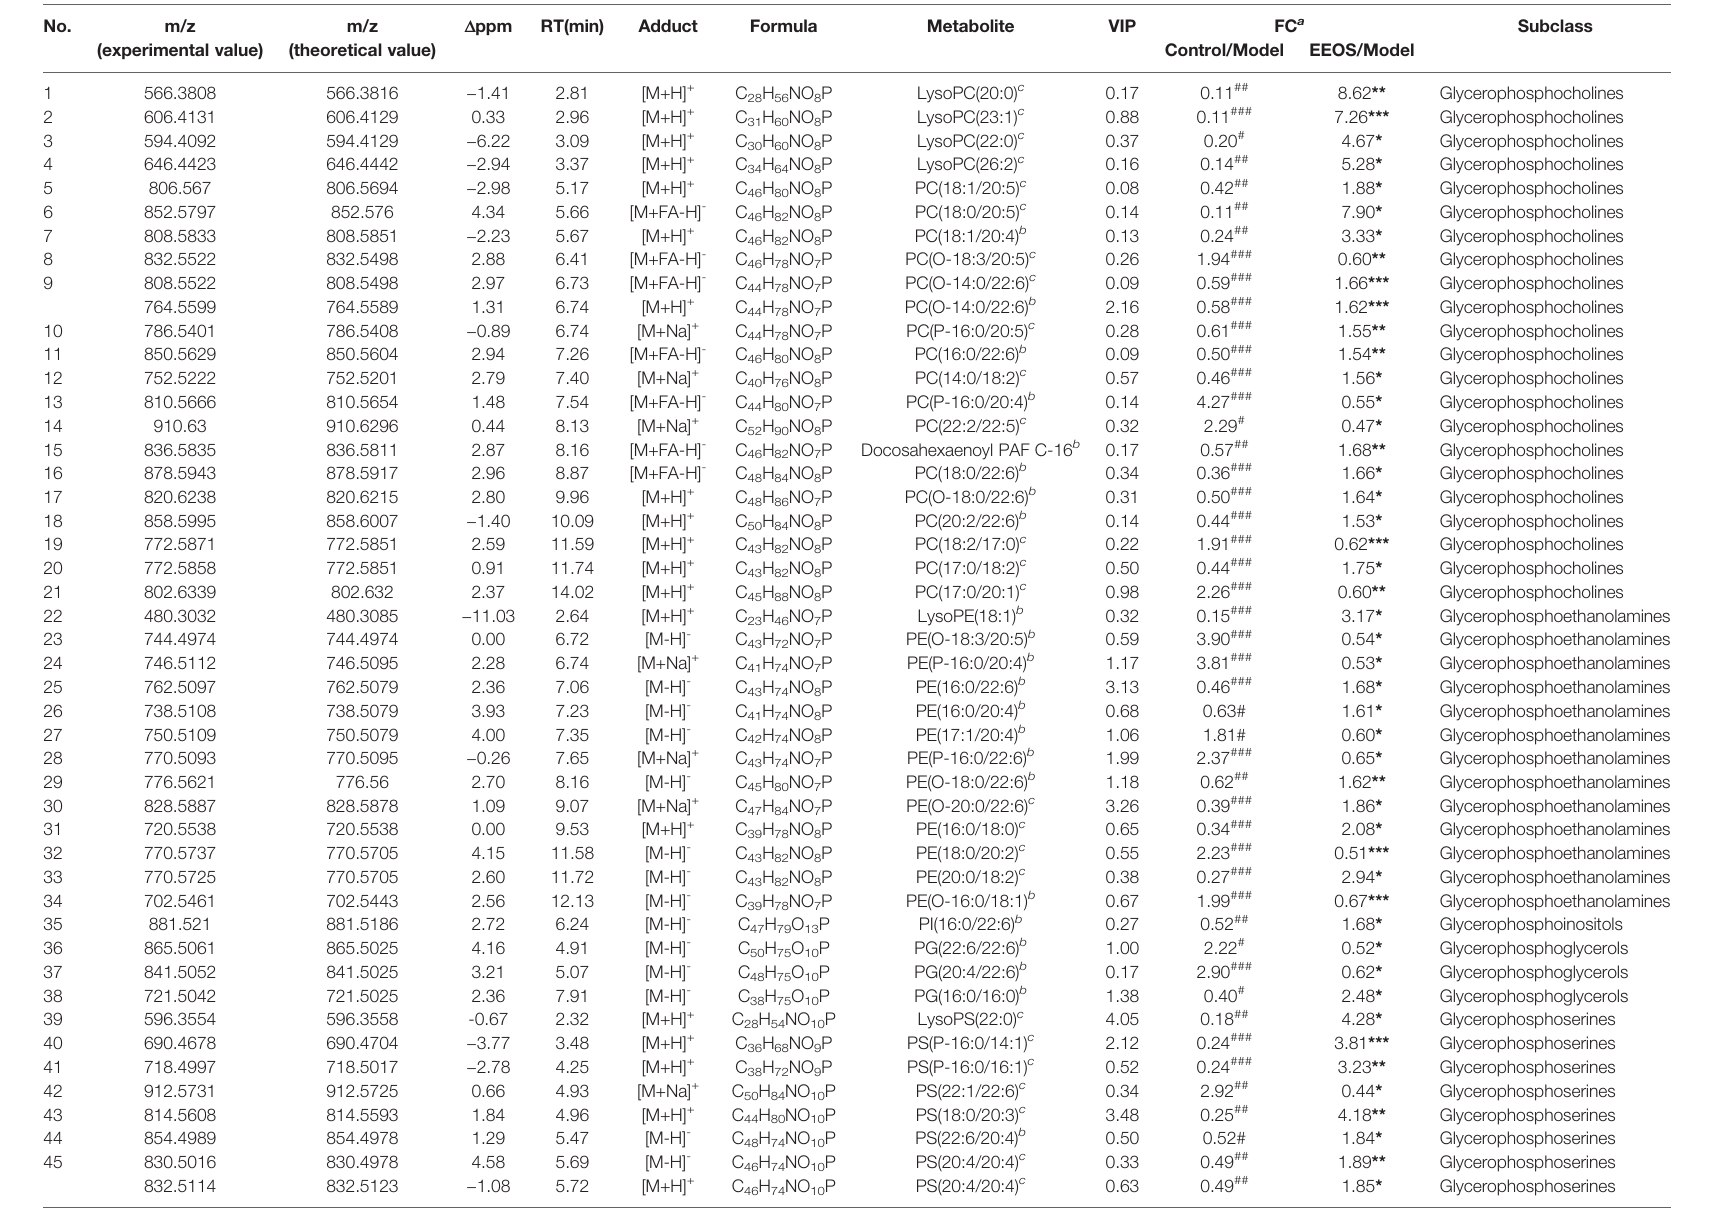
TABLE 1 | The list of differential lipids between EtOAc extract of OS (EEOS) group and model group.